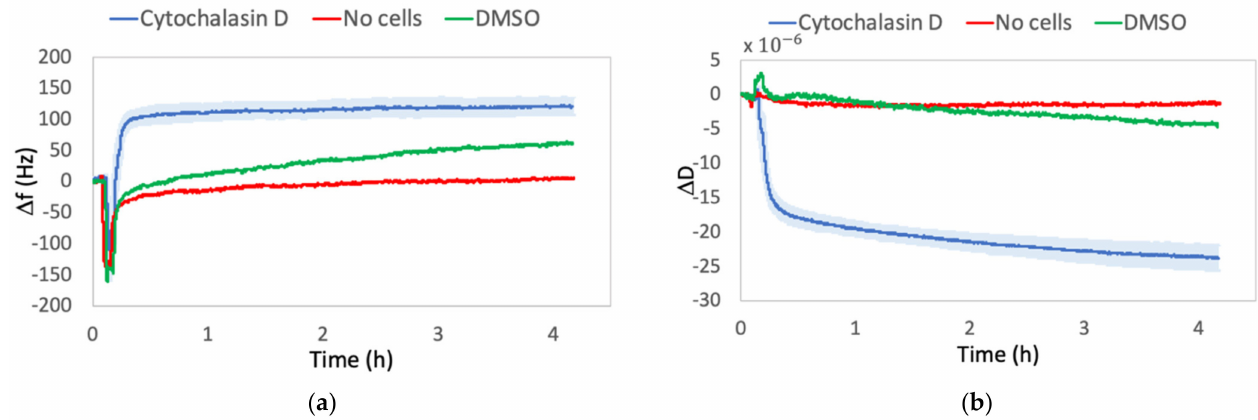
Figure 3. Comparison between ∆ f ( a ) and ∆ D ( b ) shifts in the experimental condition (Cytochalasin D) and in control condition: only drug solution in the absence of cells (No cells) or DMSO-containing medium in equal quantity as that one used for the drug solution (DMSO). The reported ∆ f and ∆ D values are relative to f and D signals, recorded from 10 min before the solution injection until the end of four hours of treatment.